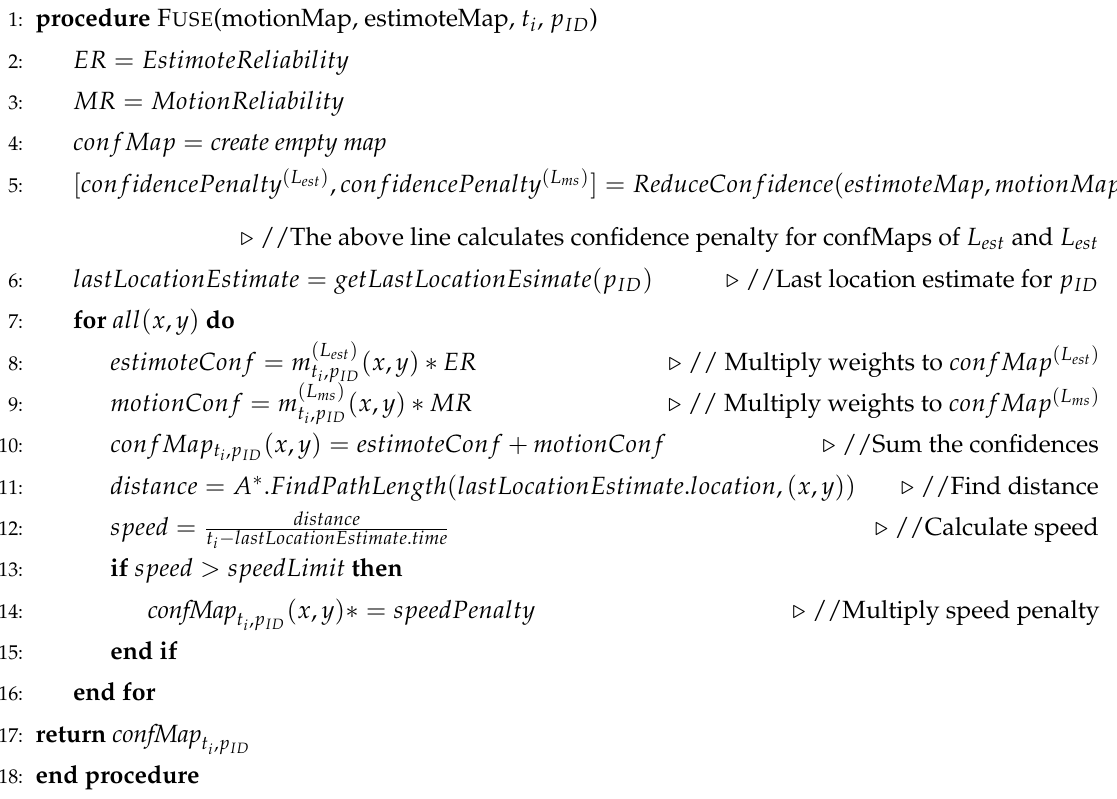
Algorithm 4 Location-Estimate